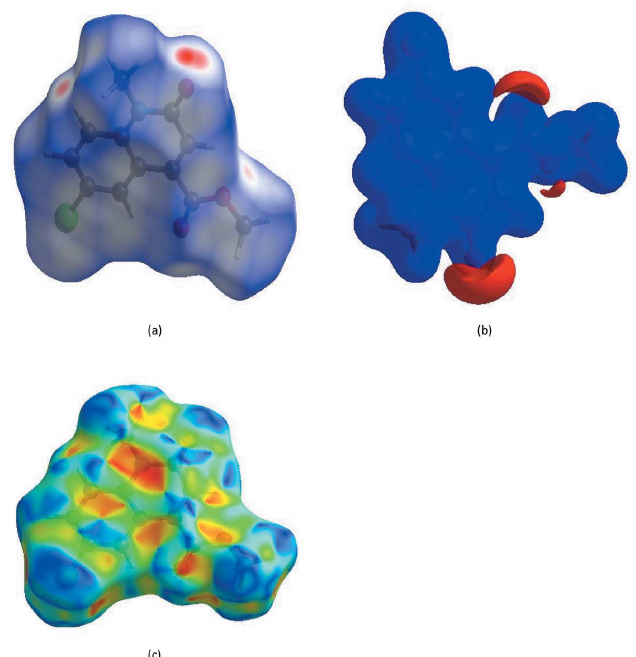
Figure 4 ( a ) View of the three-dimensional Hirshfeld surface of the title compound, plotted over d norm in the range of (cid:4) 0.2172 to 0.9151 a.u.; ( b ) view of the three-dimensional Hirshfeld surface of the title compound plotted over electrostatic potential energy in the range (cid:4) 0.0500 to 0.0500 a.u. using the STO-3 G basis set at the Hartree–Fock level of theory; ( c ) Hirshfeld surface of the title compound plotted over shape-index.